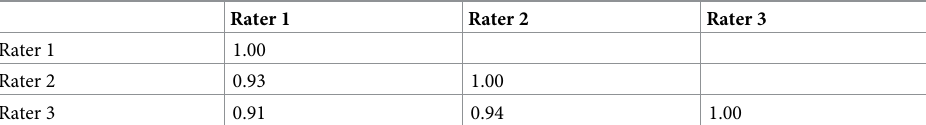
Table 2. Inter-rater reliability.